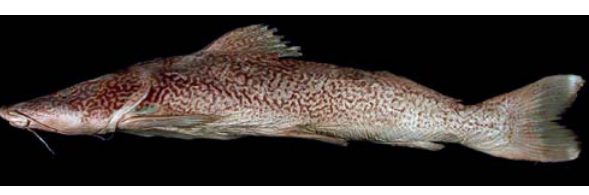
Fig. 6 . Lateral view of S . doceanum , syntype. MCZ 23794, 307 mm SL, rio Doce between Linhares and Aimorés, Espírito Santo,